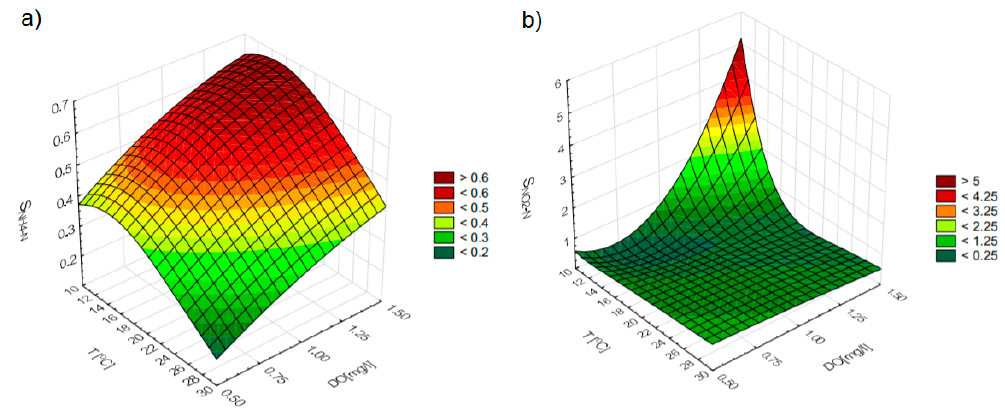
Figure 6. Of the DO set point at the defined temperature on the sensitivity coe ffi cients (Sij) for ( a ) NH 4 -N, Figure 6. of the DO set point at the defined temperature on the sensitivity coefficients (Sij) for ( a ) NH 4 - ( b ) NO 2 N, ( b ) NO 2 -N.